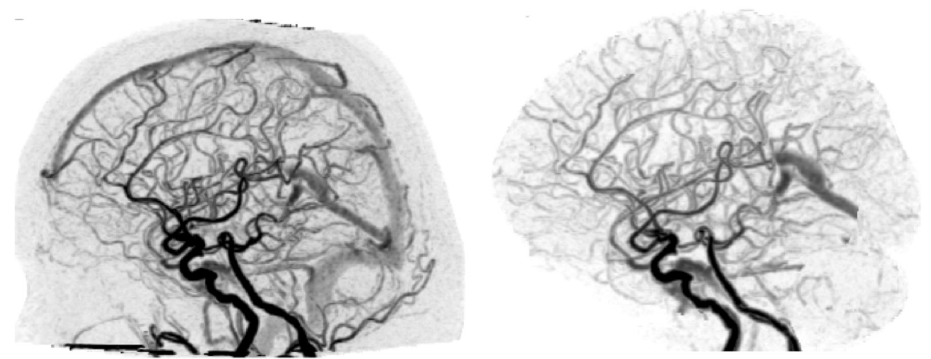
Figure 2. ( Left ) Unedited lateral-view W4D-CTA image of Case 8; ( Right ) Edited lateral-view W4D- CTA image of Case 8 where venous sinuses were omitted. W4D-CTA, whole-brain four-dimensional computed tomography angiography.